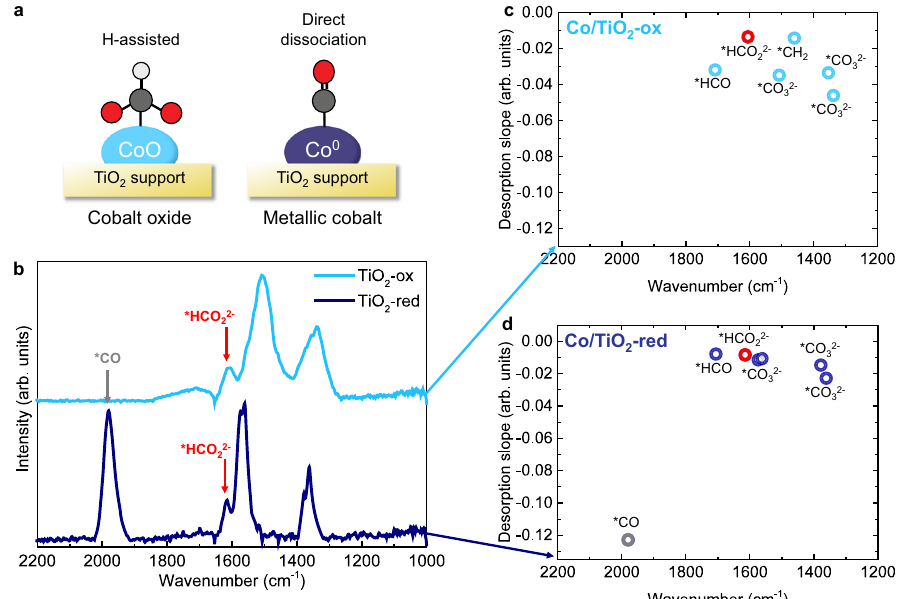
Fig. 4 Kinetic information derived from phase-sensitive detection (PSD) analysis. a Schematic representation of the H-assisted mechanism, dominant for CoO (suf fi x: -ox) catalysts, and the direct dissociation mechanism, dominant for metallic Co (suf fi x: -red) catalysts. b Phase-resolved amplitude spectra for Co/TiO 2 -ox and Co/TiO 2 -red. Desorption slopes ( fi rst 10 s after turning the CO 2 gas off) of selected species for c Co/TiO 2 -ox and d Co/TiO 2 -red. Both samples showed carbonate, formate (*HCO 2 2 − indicated in red; 1609 – 1615 cm − 1 ), and formyl species. Co/TiO 2 -ox additionally showed *CH 2 species. For Co/TiO 2 -red, *CO (gray; 1980 cm − 1 ) displayed faster kinetics (steeper slope) than the carbonate, formate, and formyl species. The direct dissociation mechanism was thus faster than the H-assisted